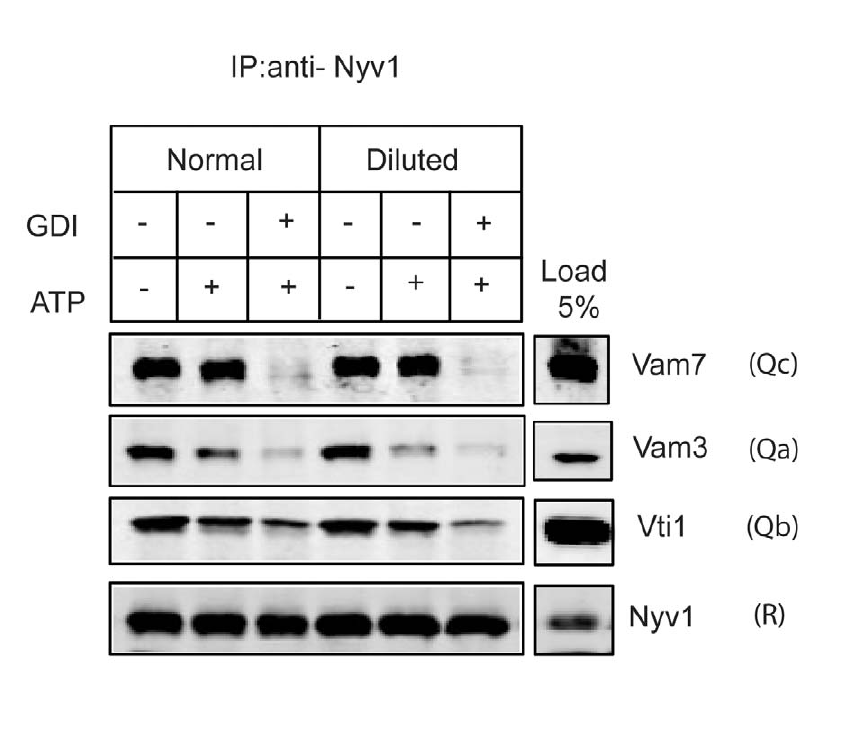
Figure 7. The Q bc R-complex stability does not depend on trans-SNARE interactions. Isolated vacuoles were either fused under standard condition or diluted up to a density of 100 m g/ml prior to the addition of salt and ATP. After incubation for 5 min at 27 u C, the standard fusion reaction (500 m g/ml) was diluted to the same density of 100 m g/ml, and 3 mM EDTA was added. After addition of Triton X-100 to a final concentration of 0.5% and brief centrifugation, Nyv1 was precipitated as described above. We found no difference in Q bc R-complex stability between diluted and non-diluted vacuoles.